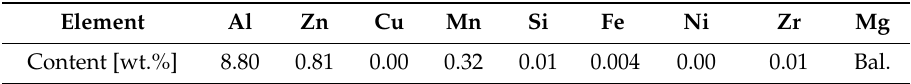
Elemental composition of the AZ91 Mg alloy, glow-discharge optical emission spectroscopy (GDOES).